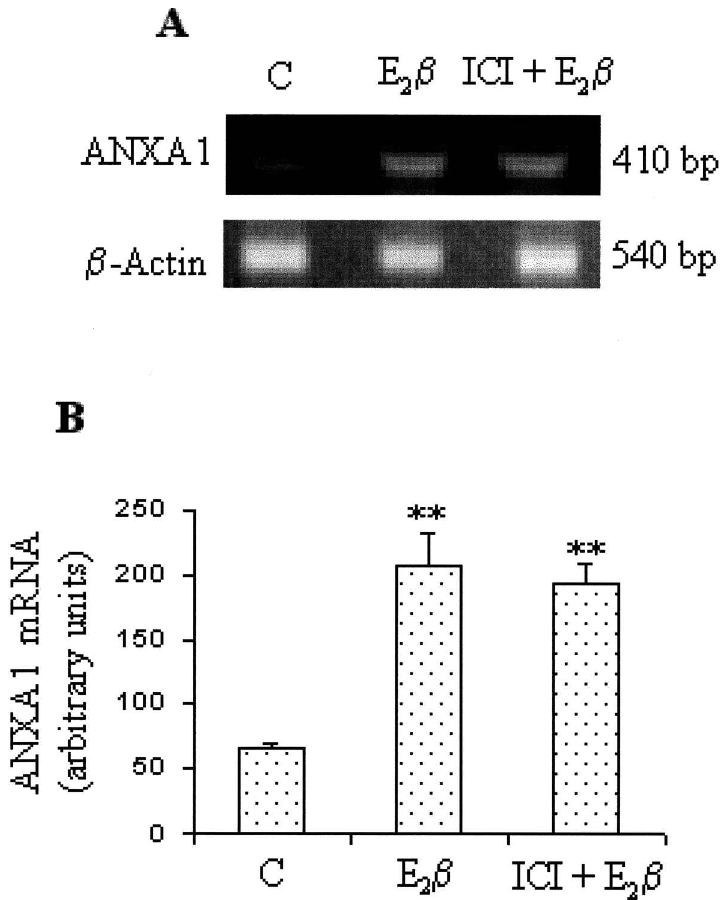
FIG. 3. Effect of E2 b and ICI 182,780 on ANXA1 mRNA synthesis in CCRF-CEM cells. Cells were incubated in the absence (control, C) and in the presence of E 2 b (1 m M), and in E2 b (1 m M) + ICI 182,780 (10 m M) for 30min (A). The bands were quantified with an image analyser (B). ANXA1 mRNA was detected by RT-PCR with a pair of primers specific for a fragment of ANXA1 mRNA. The data shown are an average of three independent experiments. Values are mean±SD, ** p < 0.01 as determined by one-way ANOVA with Dunnett’s post